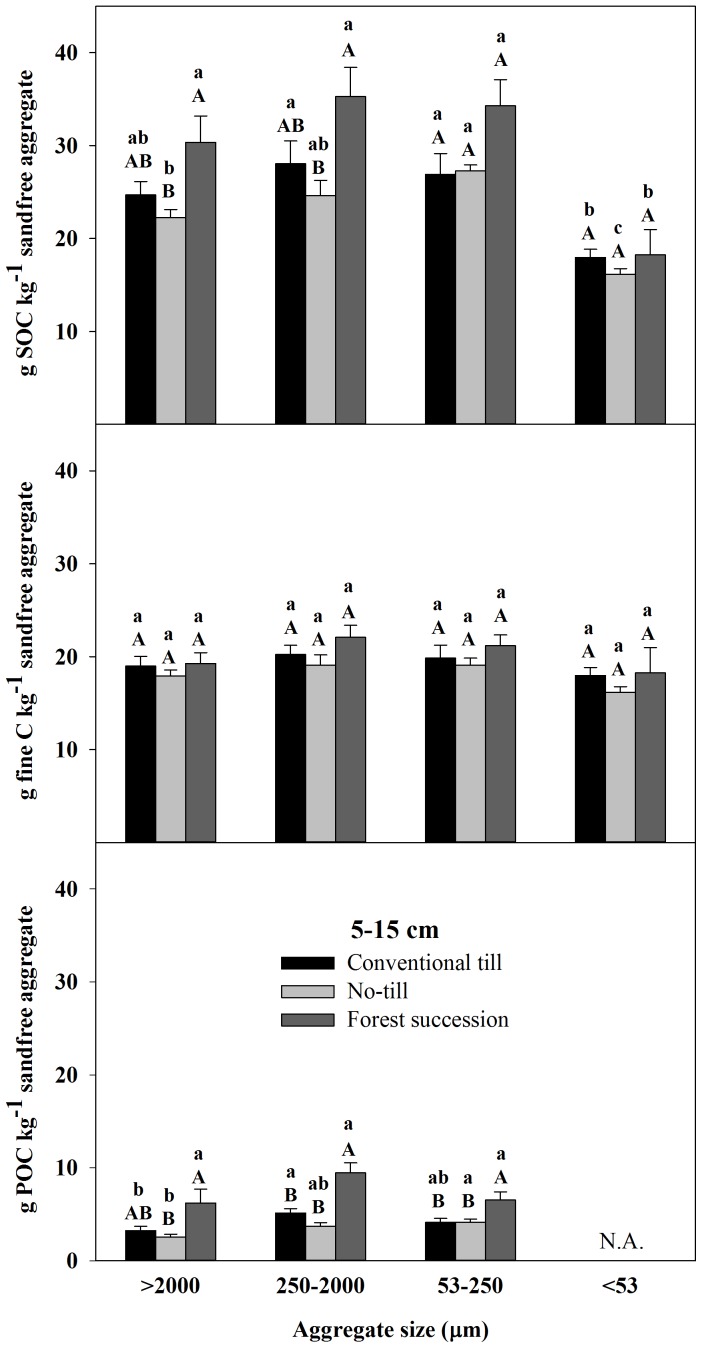
Total soil organic C (SOC), fine C (<53 µm), and particulate organic C (POC) (53–2000 µm) concentrations on a sand-free basis from 5–15 cm in four different aggregate size fractions (mean ±1 SE) in the Horseshoe Bend Agroecosystem Experiment (n = 4) Athens, GA, USA, October 2007.Different uppercase letters within an aggregate size class and C fraction represent a significant difference between land uses. Different lowercase letters within a C fraction and a land use represent a significant difference among aggregates size classes (α = 0.05). See also Table S4, part 1 and Table S4, part 2.